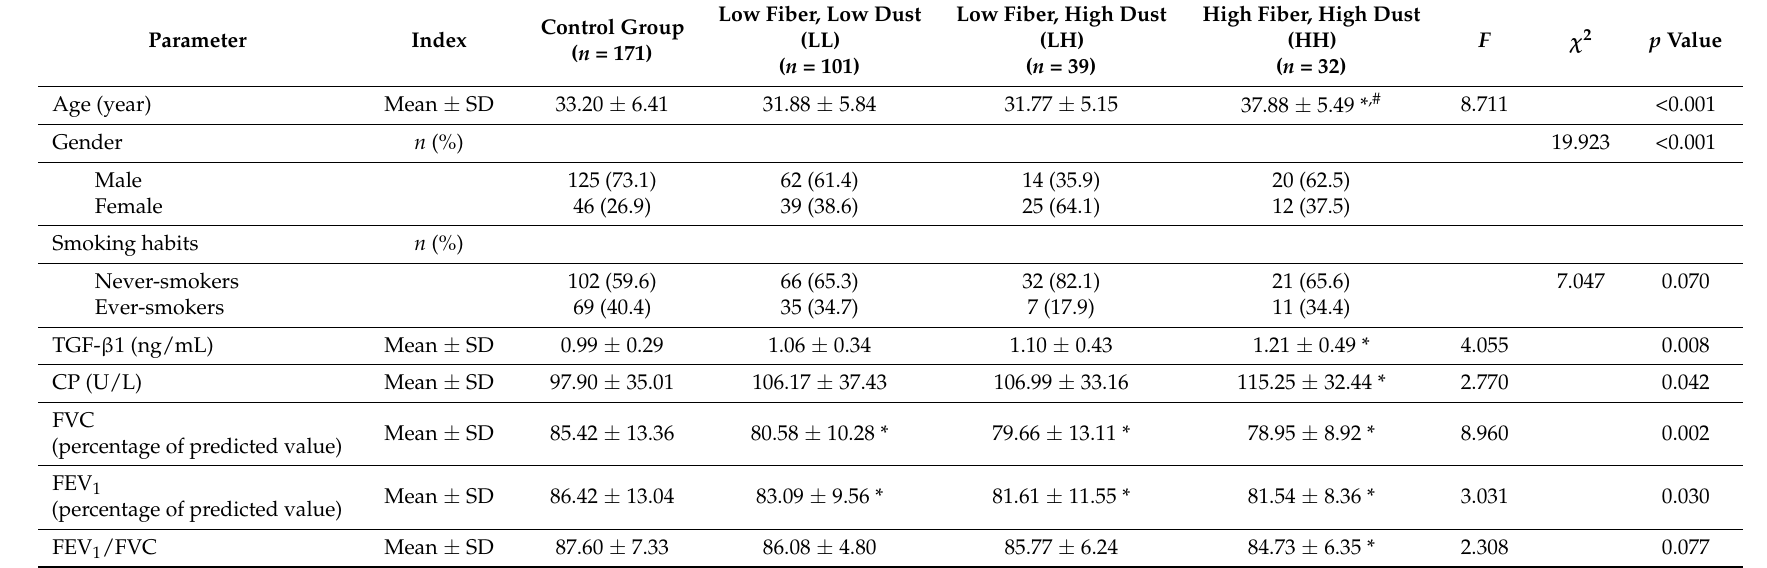
Table 2. General information of different RCFs-exposed subgroups and control